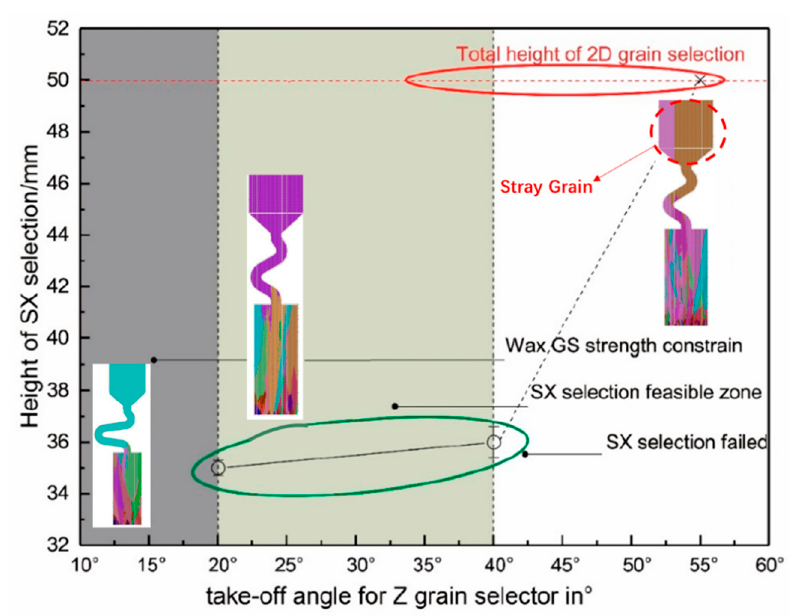
Figure 17. The simulation of different Z-type selector take-off angle with related SX height.